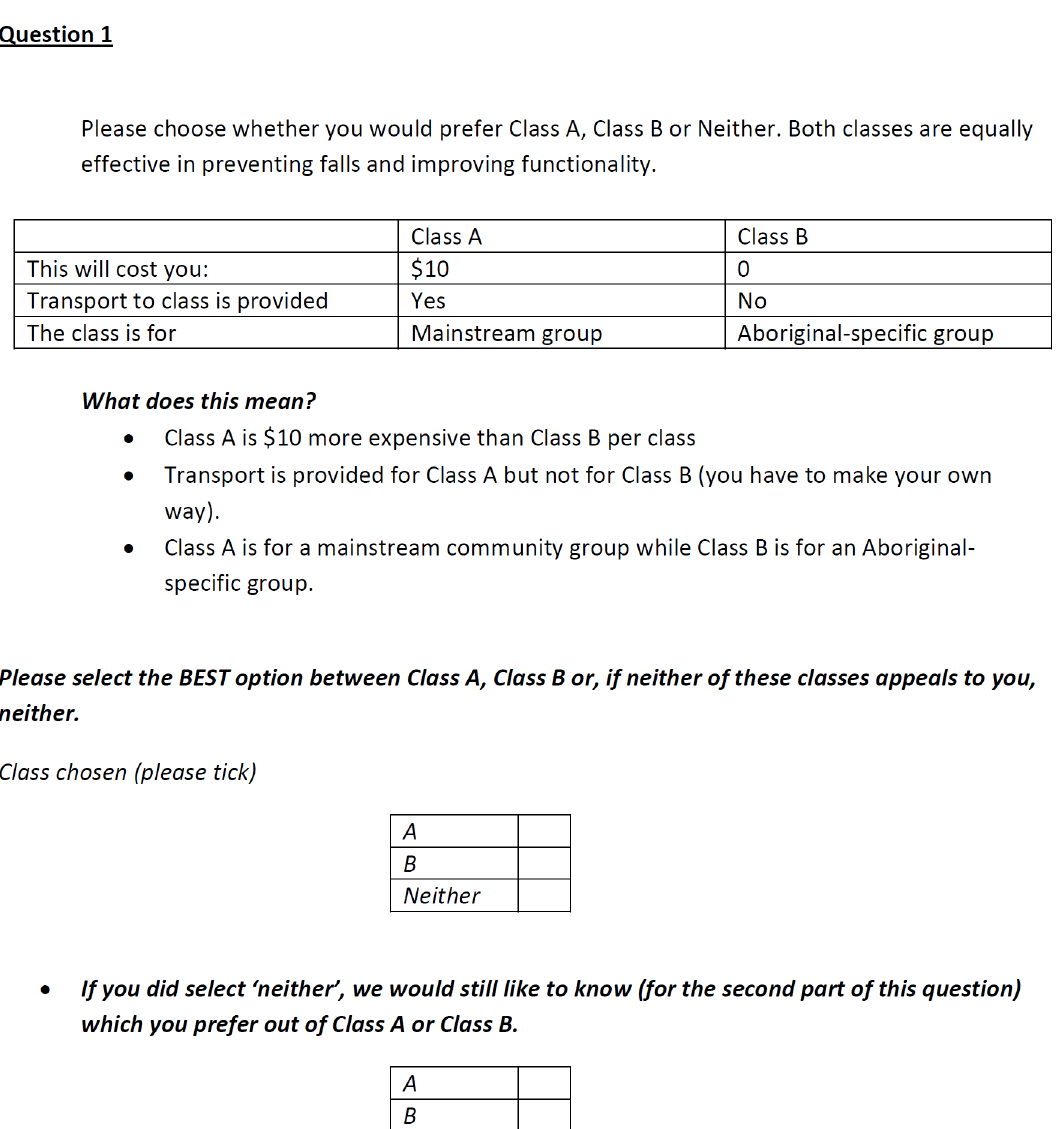
Fig 1. Example choice set presented to